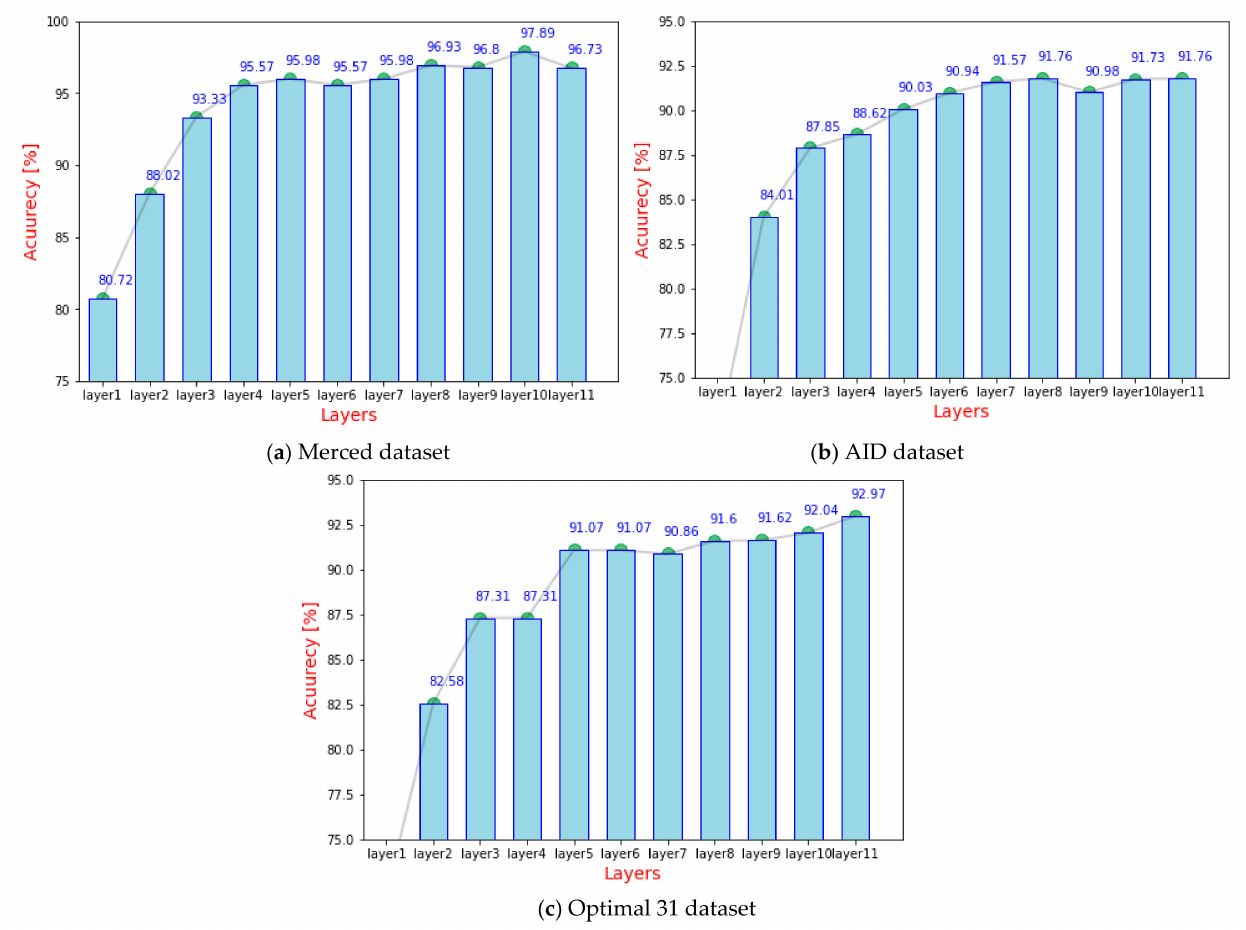
Figure 8. Relative change in model classification accuracy with respect to the encoder layers for the ( a ) Merced, ( b ) AID, and ( c ) Optimal-31